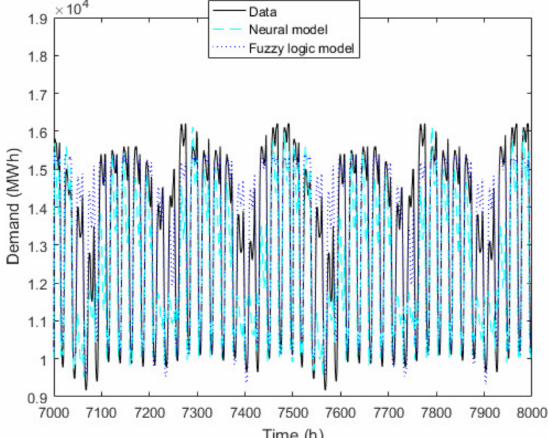
Figure 8. Generalization results of the second training